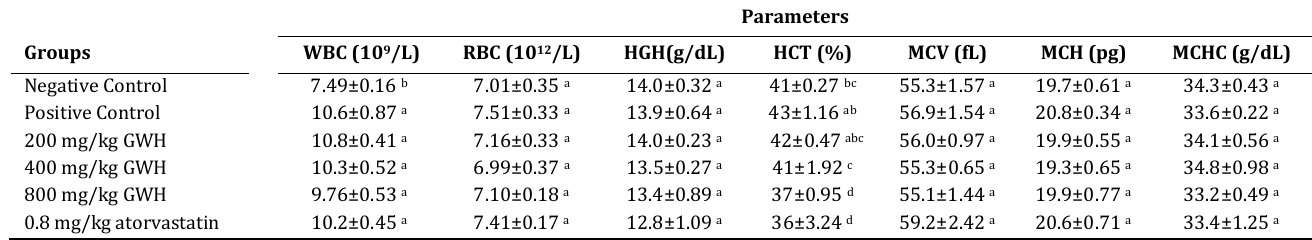
Table 3 . Effect of methanolic extract of green walnut husk (GWH) on hematological parameters of all groups after 84 days of the experiment 1